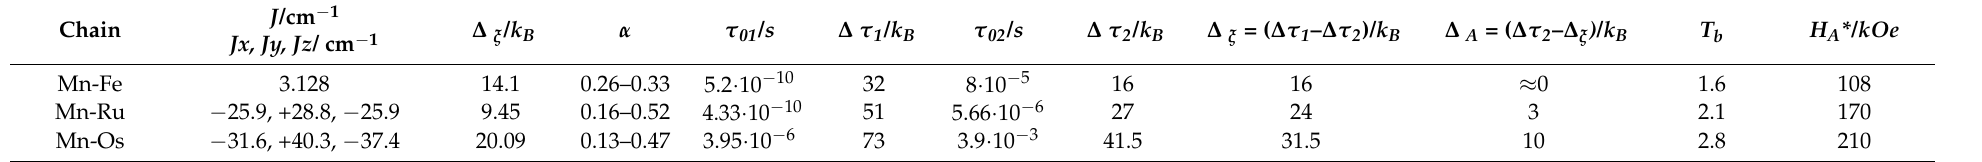
Table 2. Single chain magnet related parameters for 1 , 2 , and their Fe congener [77] (in K if not